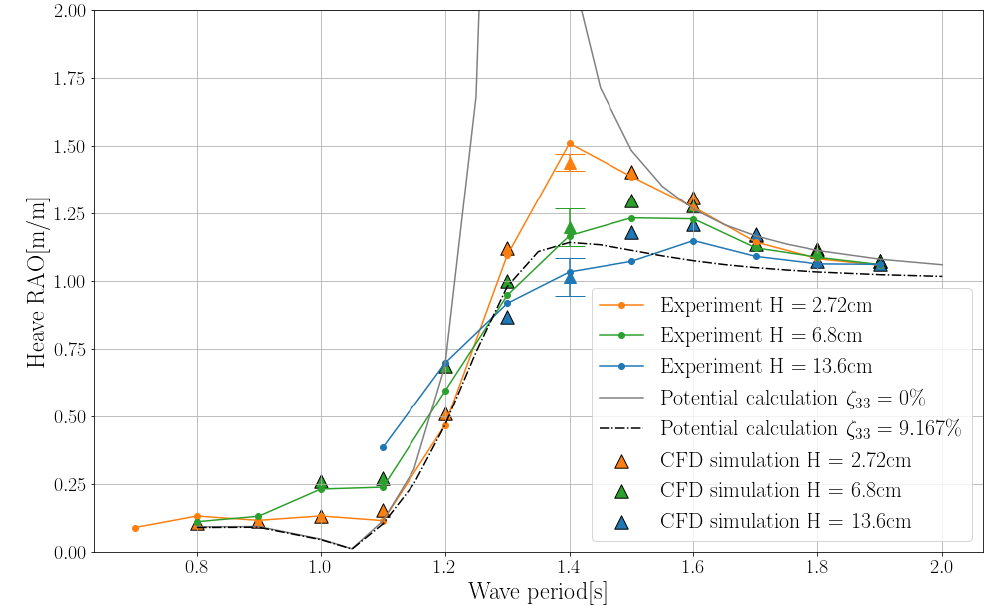
Figure 17. RAO of the heave motion of the floater in